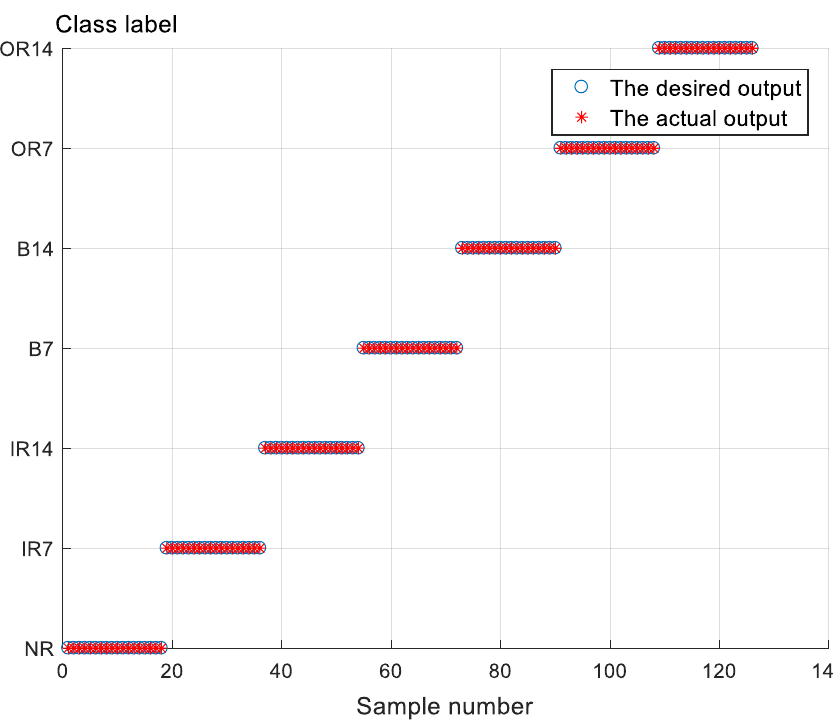
Figure 8. Classification results of the presented method in data sets: CWRU.